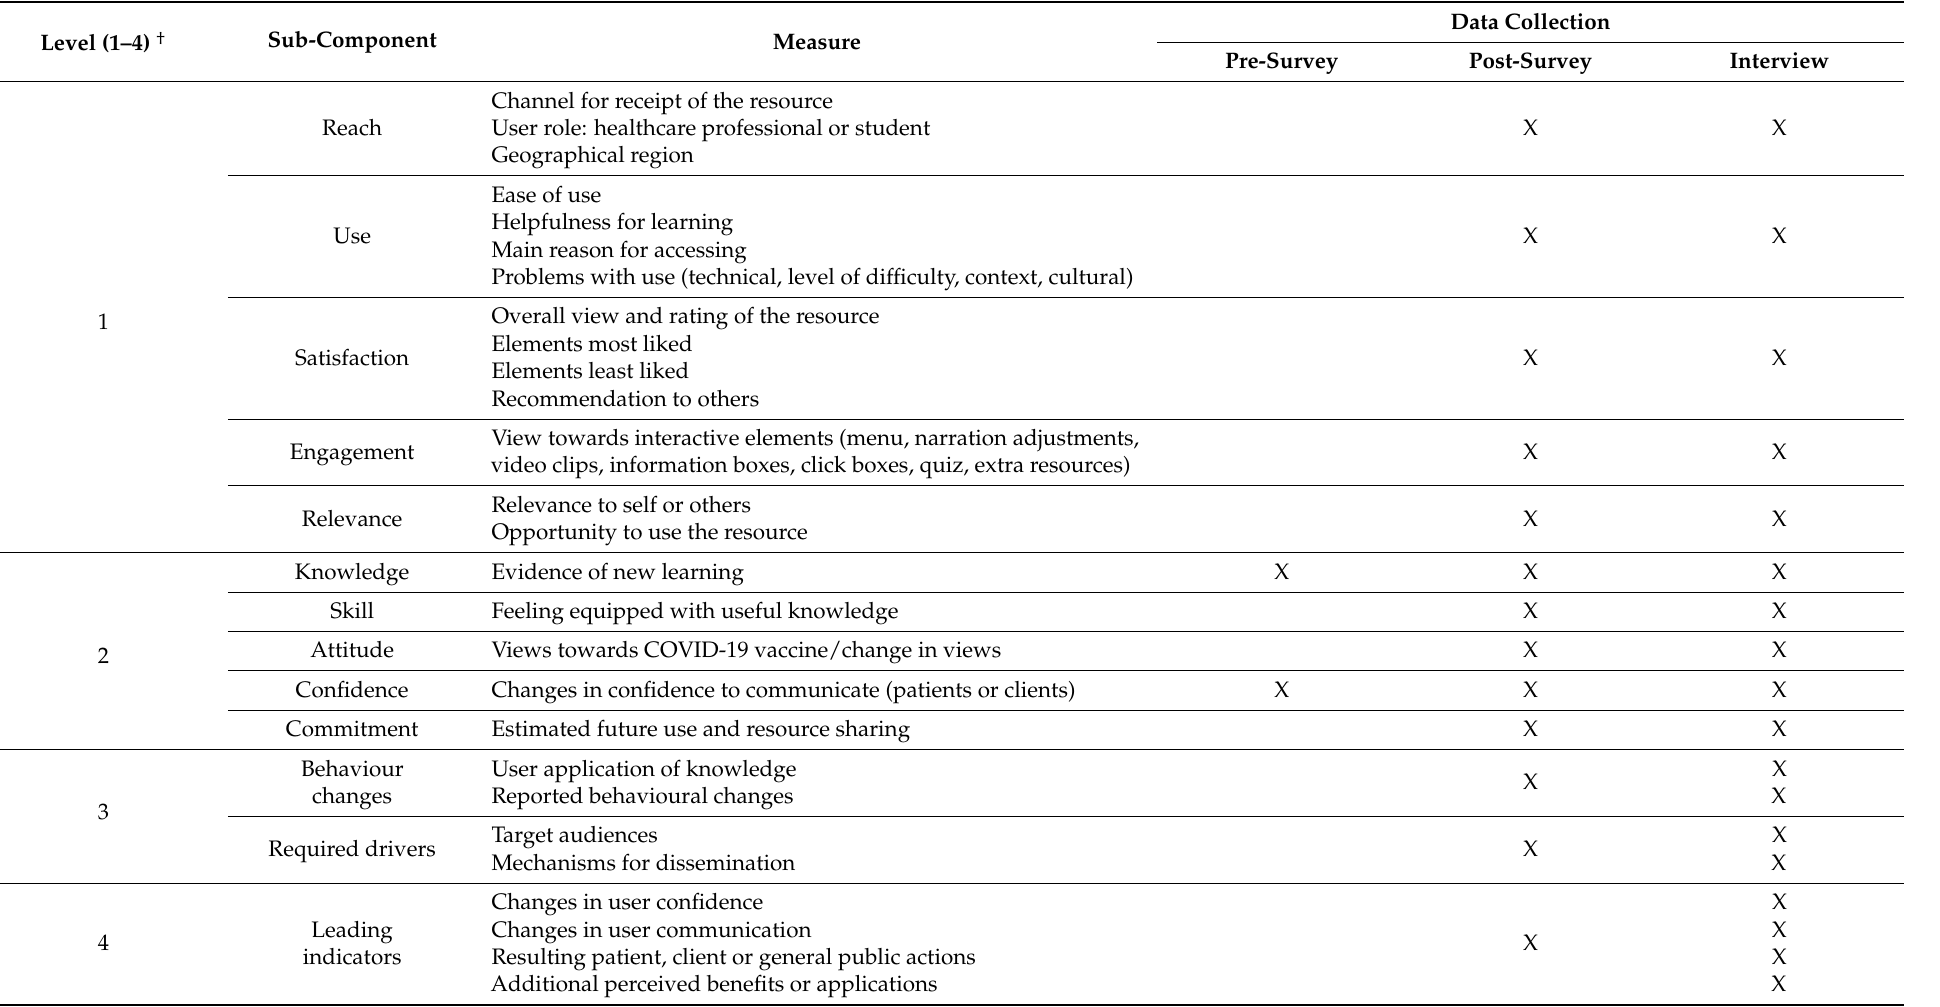
Table 2. Measurement aligned with the New World Kirkpatrick Evaluation